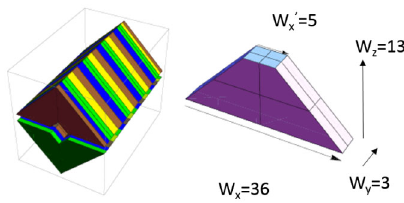
FIG. 1. Schematic picture of the deltalike magnetic